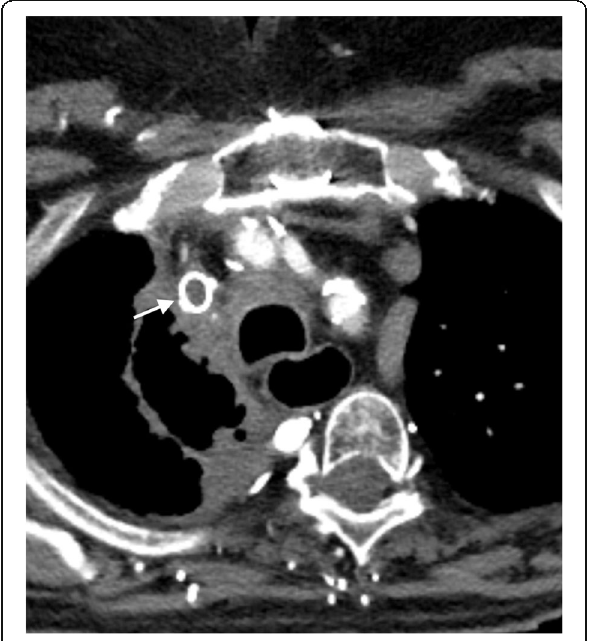
Fig. 14 Thrombosed stent. Axial CT image demonstrating a patient who has a thrombosed stent within the SVC